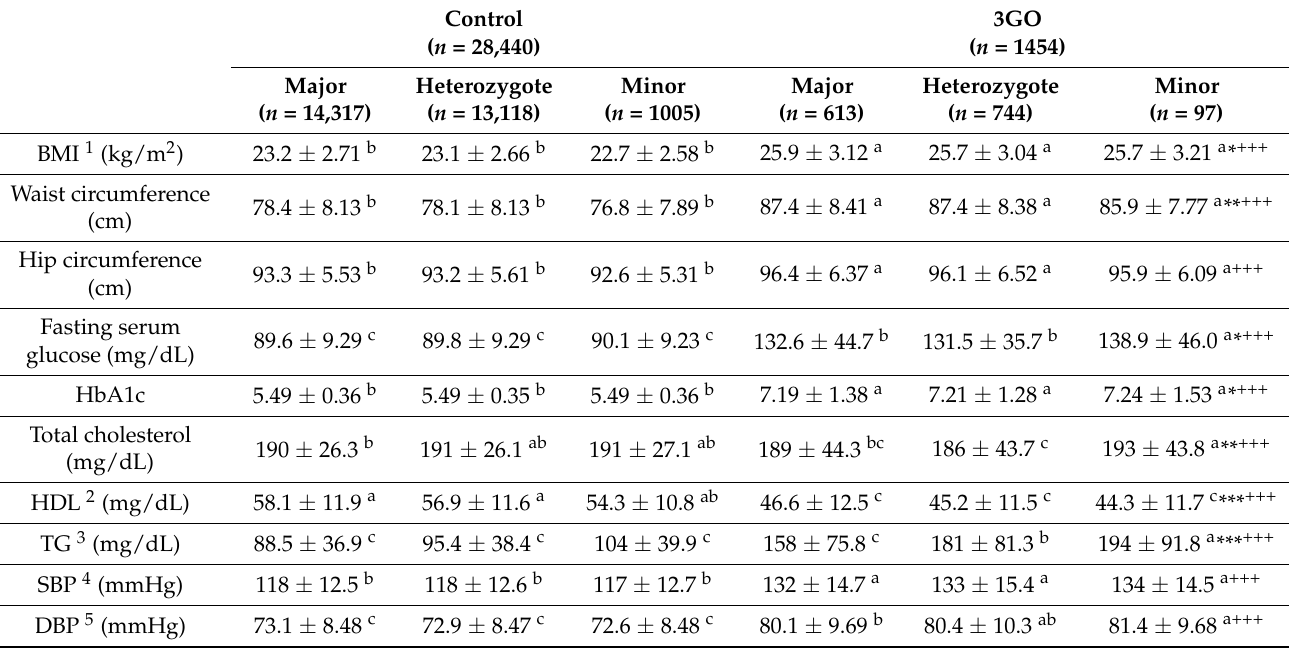
Table 3. Adjusted means and standard deviations according to haplotype allele and control and 3GO